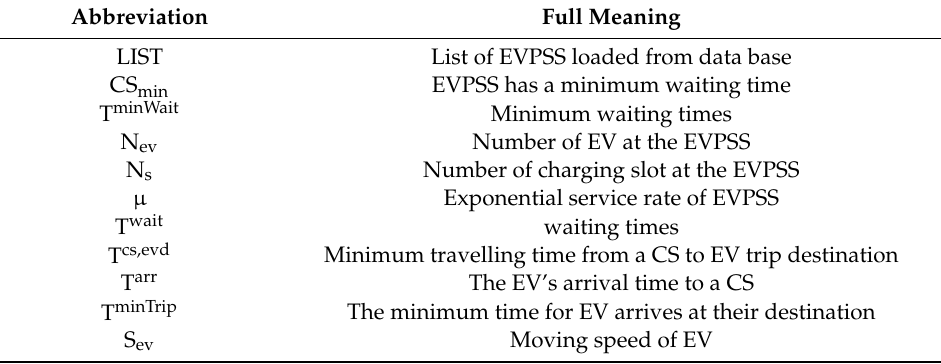
Table 1. List of